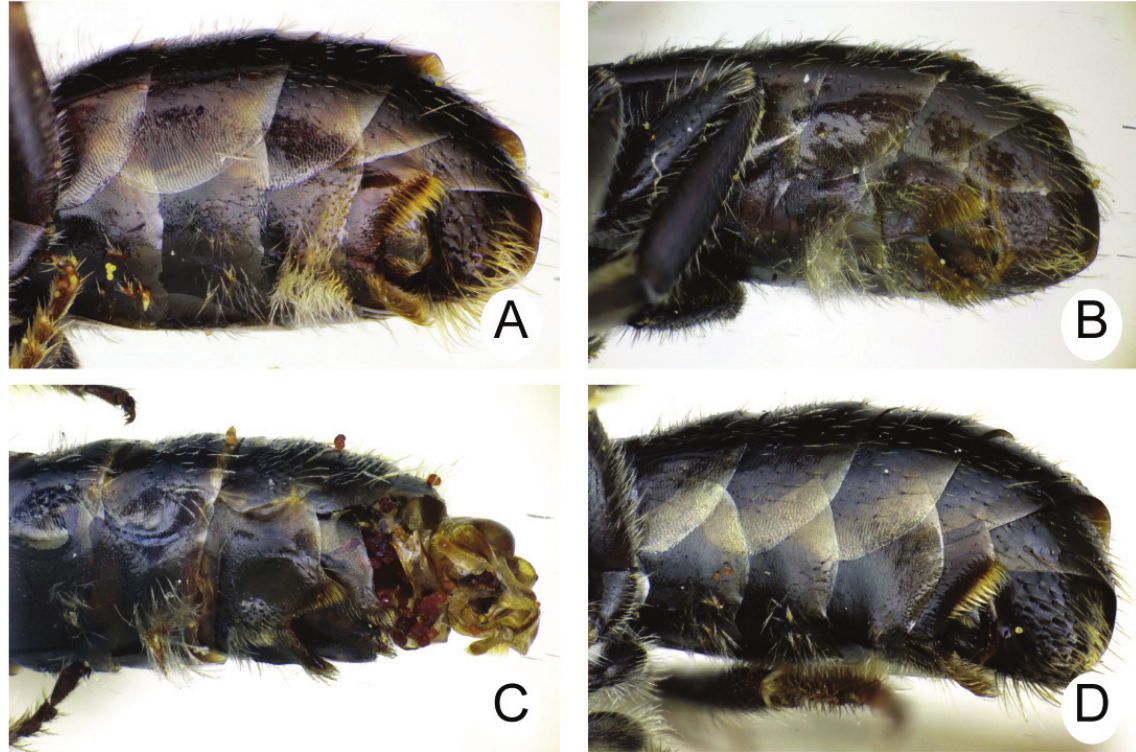
Fig. 13. hairs on metasomal sterna in species of the problematicum subgroup, ♂. A . Lasioglossum ( Dialictus ) problematicum (Blüthgen, 1923). B . Lasioglossum ( Dialictus ) sanitarium (Blüthgen, 1926). C . Lasioglossum ( Dialictus ) sichuanense Fan & ebmer, 1992. D . Lasioglossum ( Dialictus ) alishanense Murao sp. nov.,